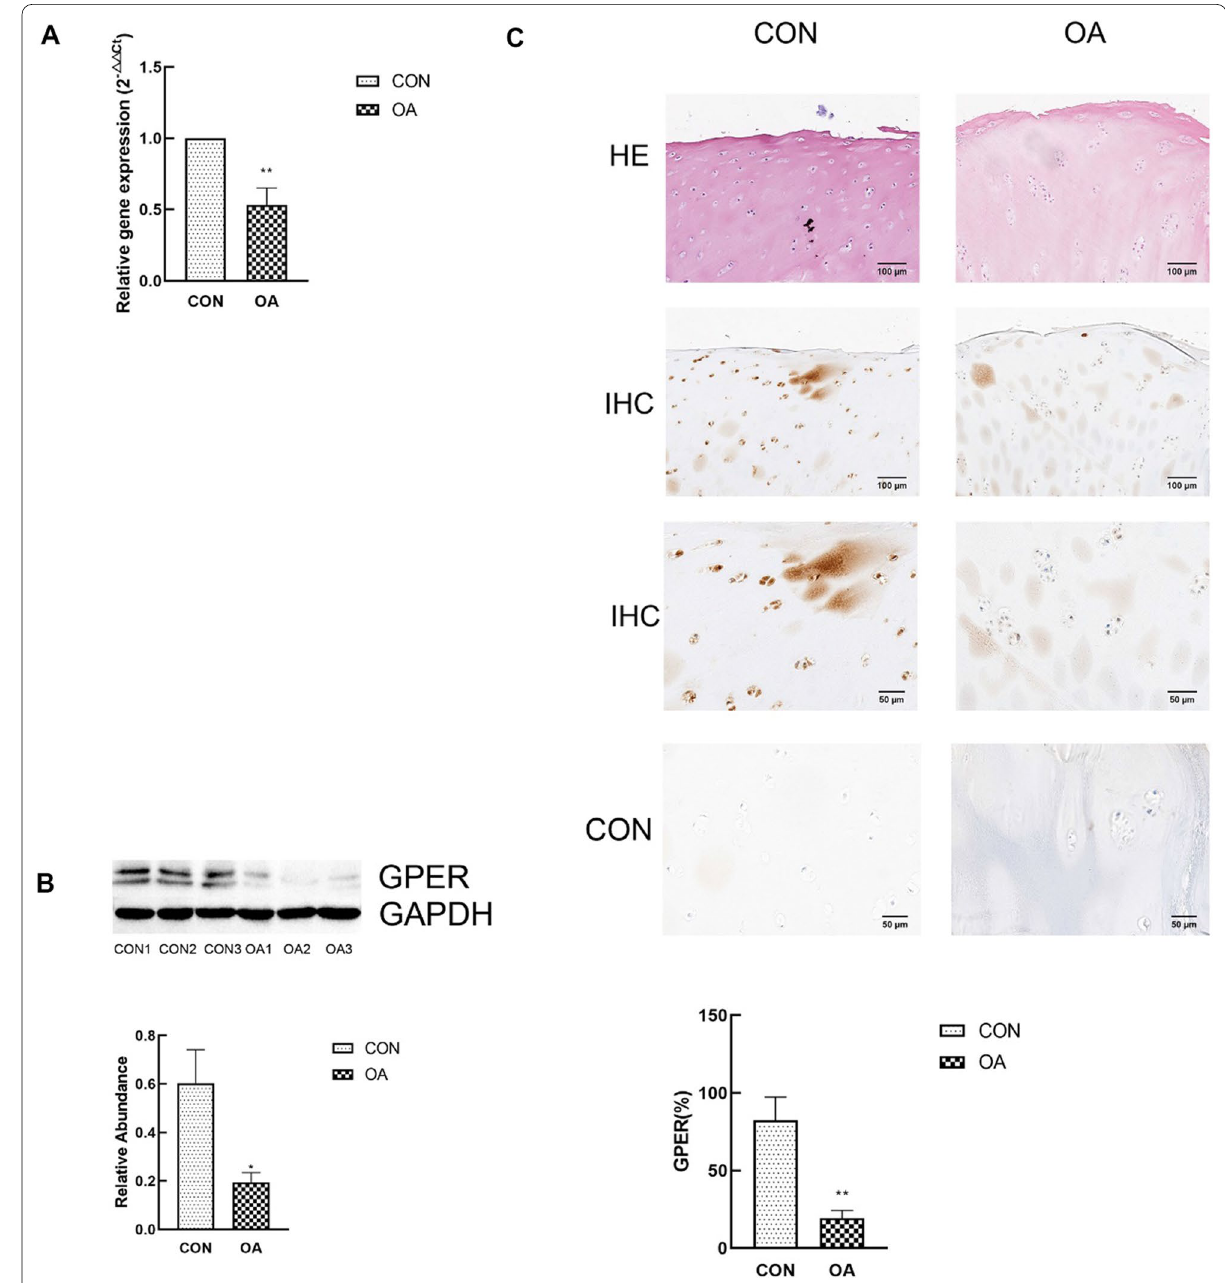
Fig. 2 GPER expression is decreased in human osteoarthritis cartilage. a RT-qPCR analysis of GPER genes in degenerative cartilage compared with control cartilage (n 10). b Protein expression of GPER in degenerative cartilage compared with control cartilage (n = staining of degenerative cartilage and control cartilage without (control) and with anti-GPER antibody (n *P < 0.05, compared with control cartilage. **P < 0.01, compared with control